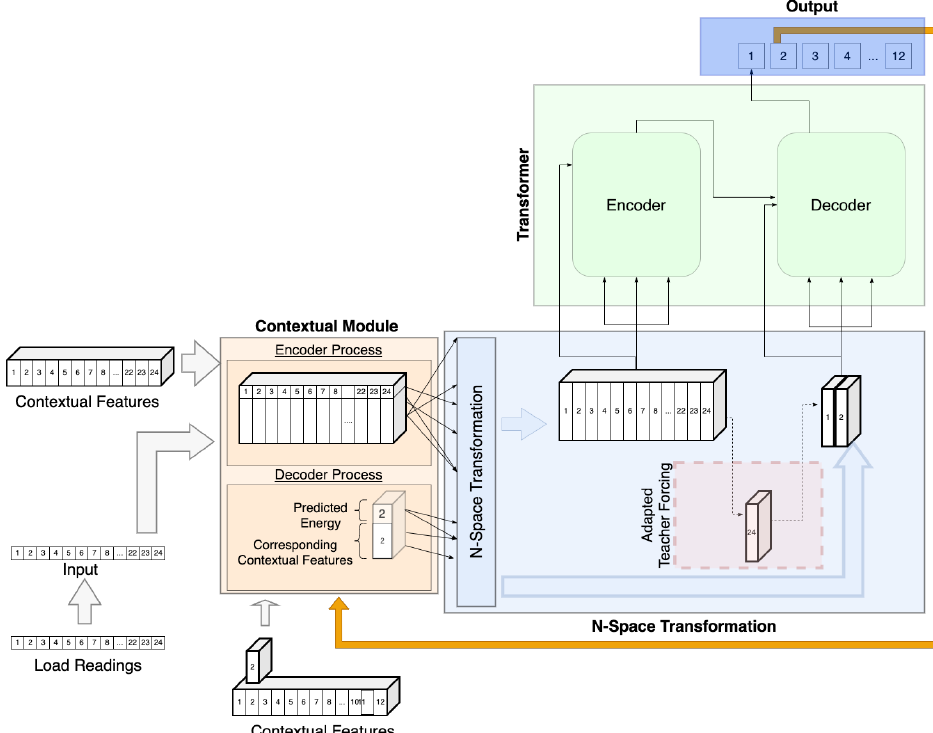
Figure 3. Load forecasting inference workflow of the transformer